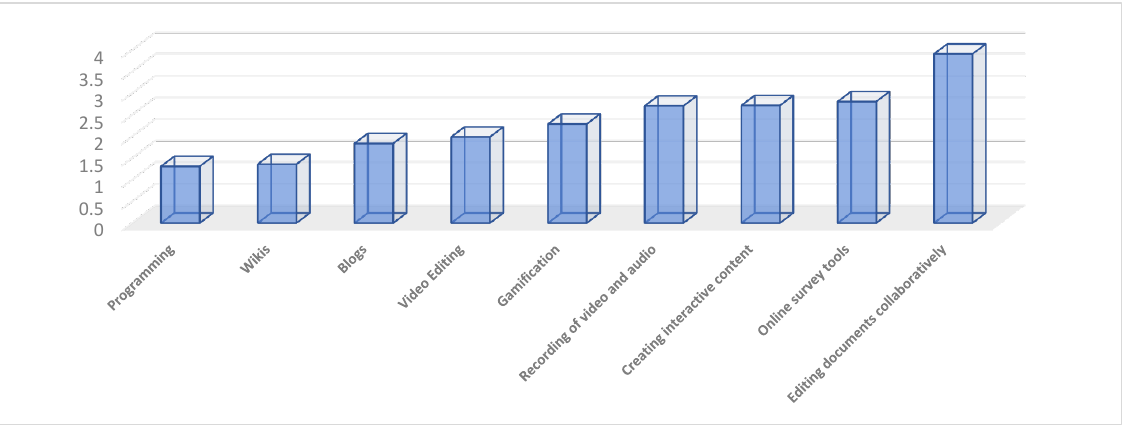
Figure 3. Average frequency of use of digital tools or applications for instructional design.